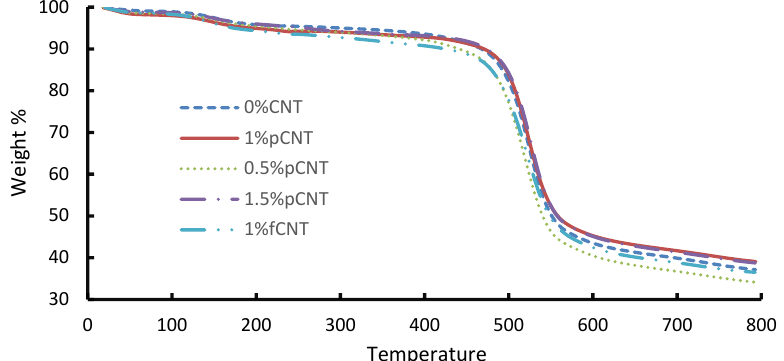
Figure 1. TGA curves of blended polysulfone (PSF)/polyethersulfone (PES) membranes with different CNT concentrations .